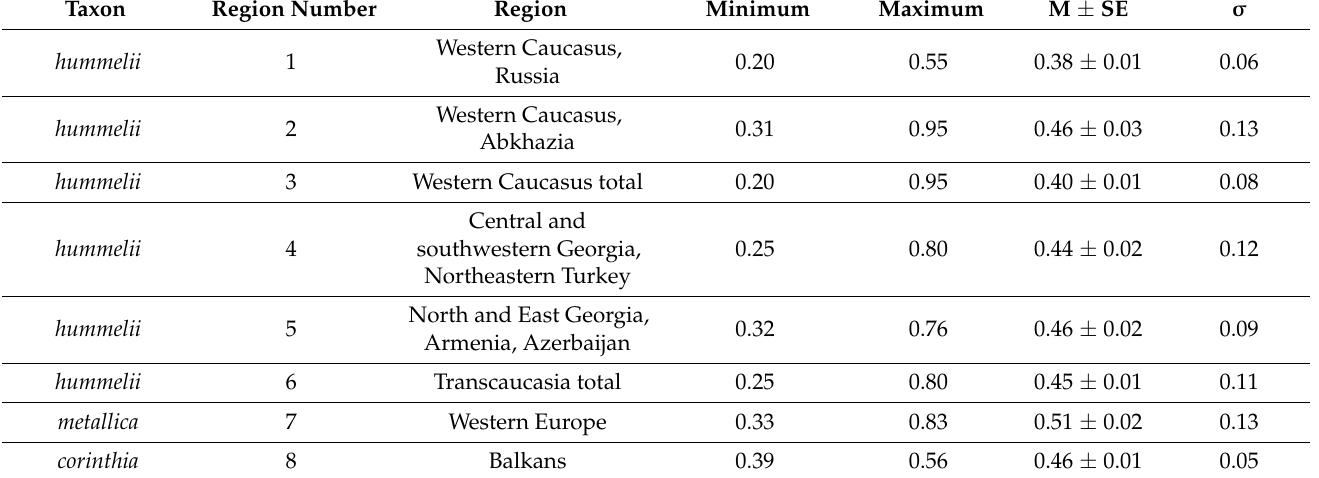
Table 6. Location of the maximal width of the pronotum: distance from the level of the front corners to the level of the greatest width of the pronotum/total length of the pronotum (both in dorsal view). M—mean value, σ —standard deviations, SE—standard